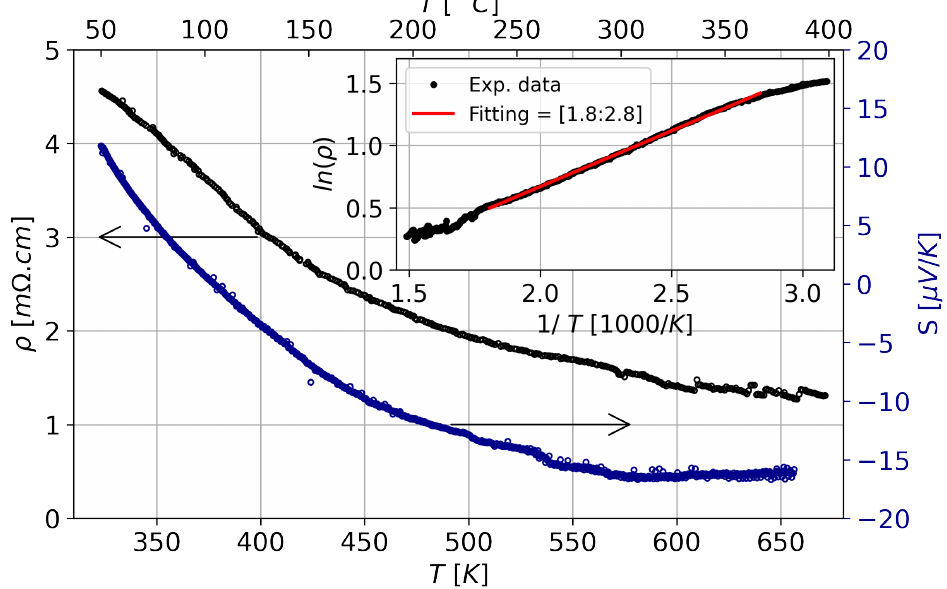
Figure 4. Temperature dependence of electrical resistivity ρ (black open circles, left y-axis indicated by the left arrow) and Seebeck coefficient ( S ) (dark blue open circles, right y-axis indicated by the right arrow) measured after RSPS. Inset highlights ρ data in an Arrhenius presentation. The red solid line indicates the result of a linear fit to the data representing an activation energy E g ≈ 0.145 ± 0.015